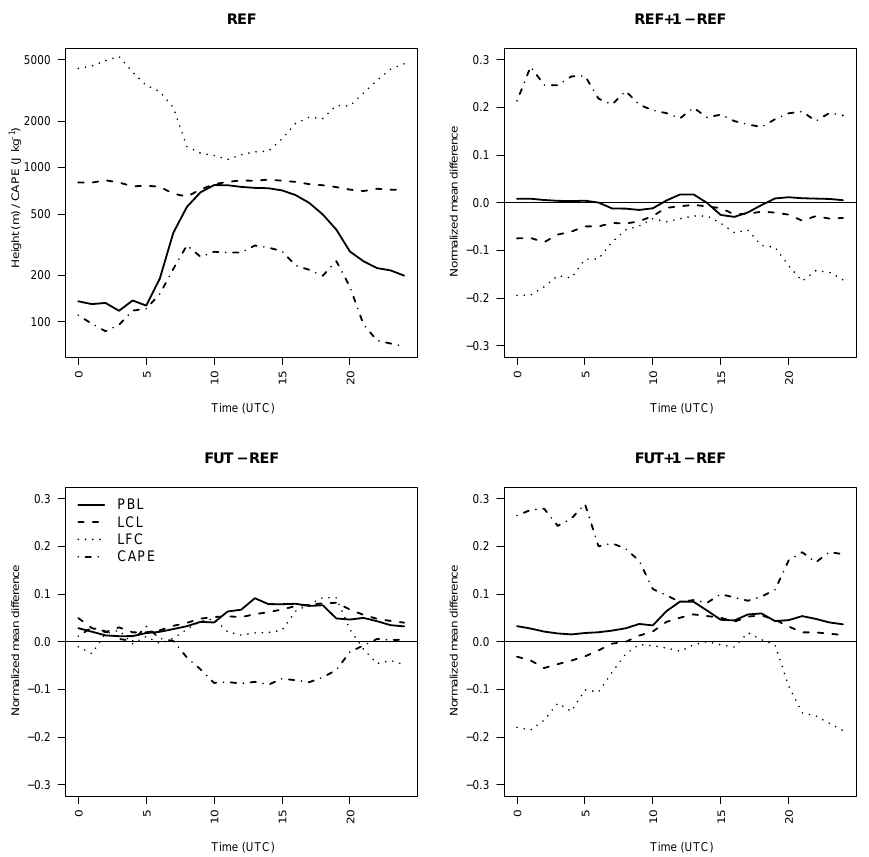
Figure 11. Diurnal cycle of the planetary boundary layer (PBL, solid), lifting condensation level (LCL, dashed), level of free convection (LFC, dotted) (m), and convective available potential energy (CAPE, dash-dotted) (Jkg − 1 ) in the reference experiment and normalized mean difference of these variables in the experiments with a temperature perturbation and reference land cover (REF+1), future land cover (FUT), and a temperature perturbation and future land cover